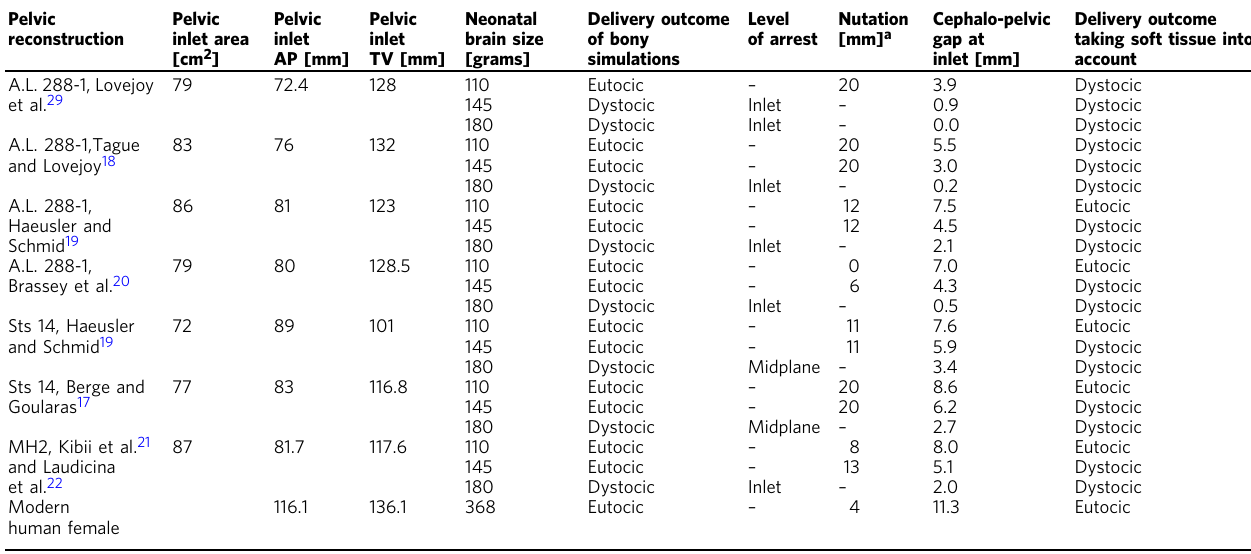
a Nutation represents outlet expansion by backward rotation of the caudal tip of the